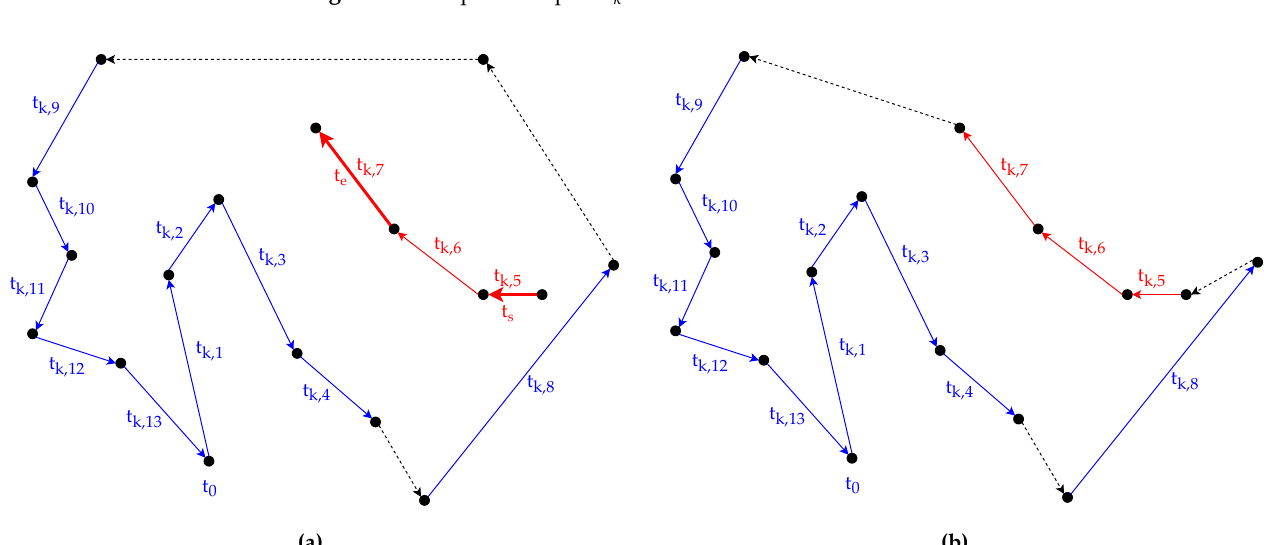
subtracted from route plan r k ; k k